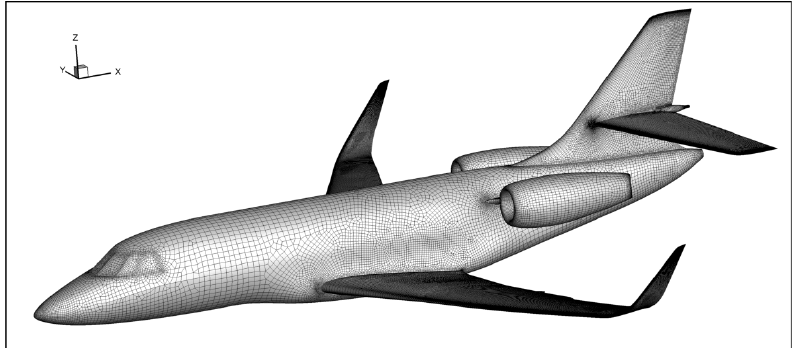
Figure 10. DLR-ISTAR surface mesh of the complete aircraft including engines.